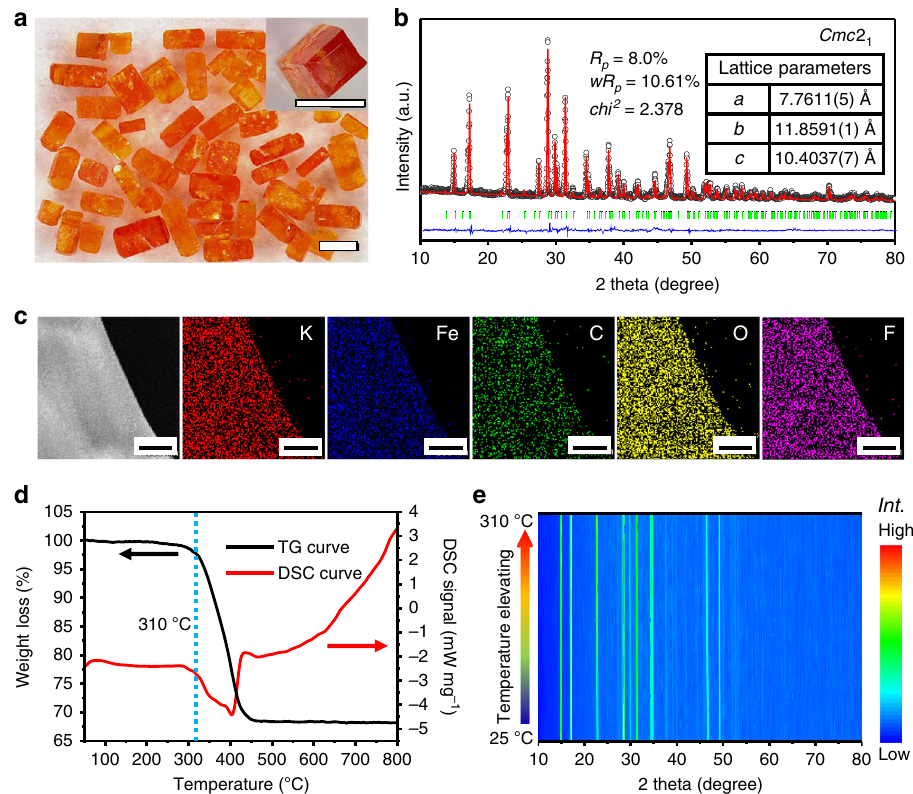
Fig. 1 Characterization of KFeC 2 O 4 F. a Optical images of as-synthesized crystallites. The inset shows a tetra-prismatic single crystal in the size of ~ 1.0 × 0.6 × 0.5 mm. (scale bar = 1 mm) b Rietveld fi tness of powder XRD (Cu K α ) on a pristine sample. The inset shows the result of the fi tness. c TEM and corresponding EDS mapping of K, Fe, C, O, F. (scale bar = 500 nm) d TG and DSC curves of a powder sample. e Variable – temperature XRD from 25 °C to 310 °C in air gas fl ow (Cu K α